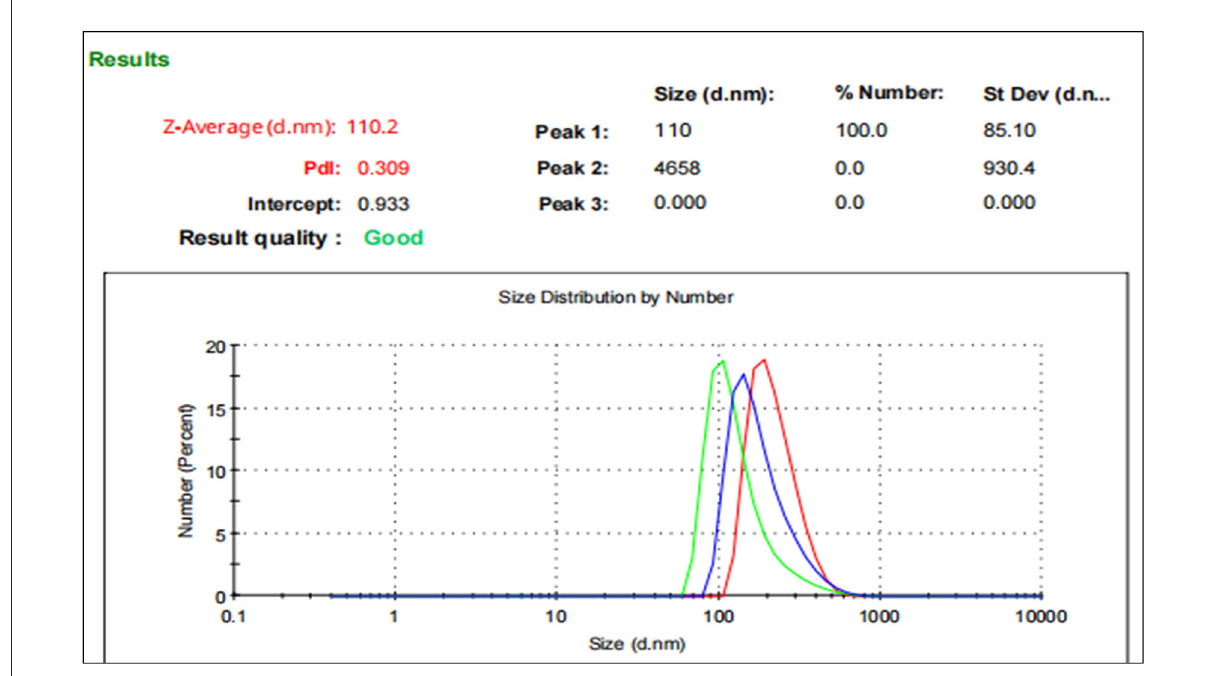
FIGURE5 Particle size of optimized formulation.